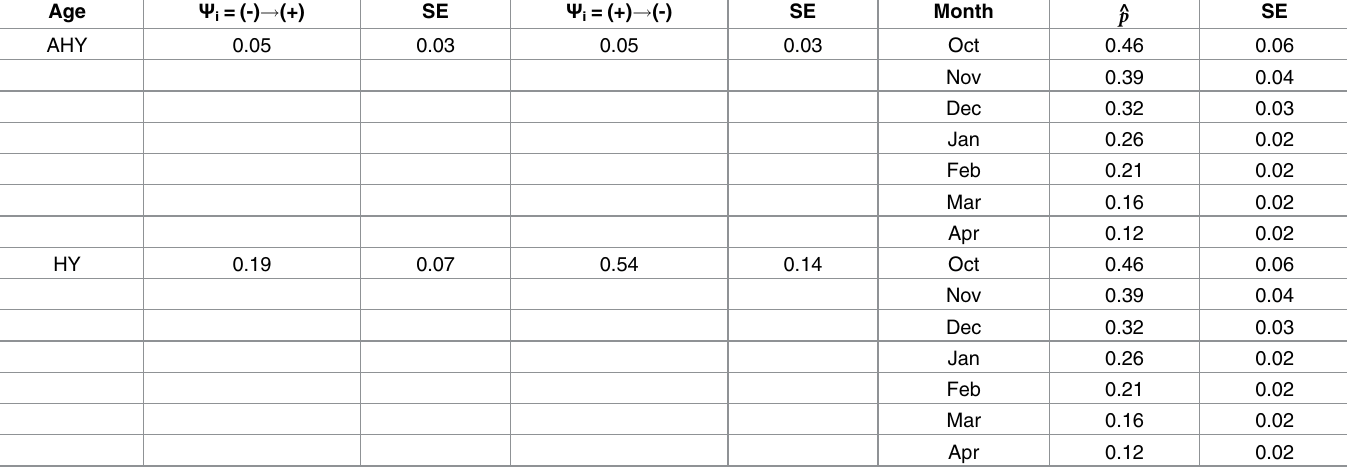
ture occasions within the same year. Eight of these individuals were sampled in Fairbanks dur- ing 2012/13 (Table F in S1 File) and 31 individuals were sampled in Anchorage during 2014/15 (Table G in S1 File). The single individual recaptured during 2013/14 in Fairbanks was excluded from analysis. We identified antibody titers to some (10/12) H1 –H12 HA subtype viruses in recaptured mallards sampled in Fairbanks in 2012/13 and all H1 –H12 HA subtype viruses in recaptured mallards sampled in Anchorage during 2014/15 (Fig 3). For recaptured mallards sampled in Fairbanks in 2012/13, we had sufficient data to assess trends in antibody titers for six HA viral subtypes (Fig 4). Antibody titers to H5 subtype IAVs appeared to decrease between capture occasions, while antibody titers to other IAV subtypes (H3, H4, H7, H11, H12) were Table 5. Estimatesof serostatus transition probability ( Ψ i) and capture probability ( ^ p ) from the top approximating model for adult (AHY) and juve- nile (HY) mallards captured in Anchorage, Alaska from September through April (2014/15). Seroconversion (-) ! (+) and seroreversion(+) ! (-) esti- mates are representative of each age